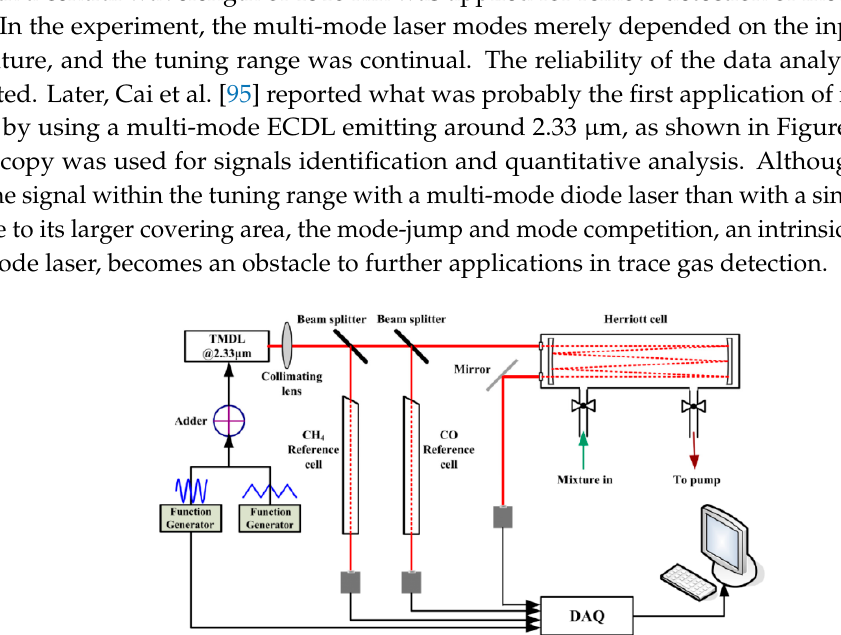
Table 1. Some parameters of novel multipass cells.